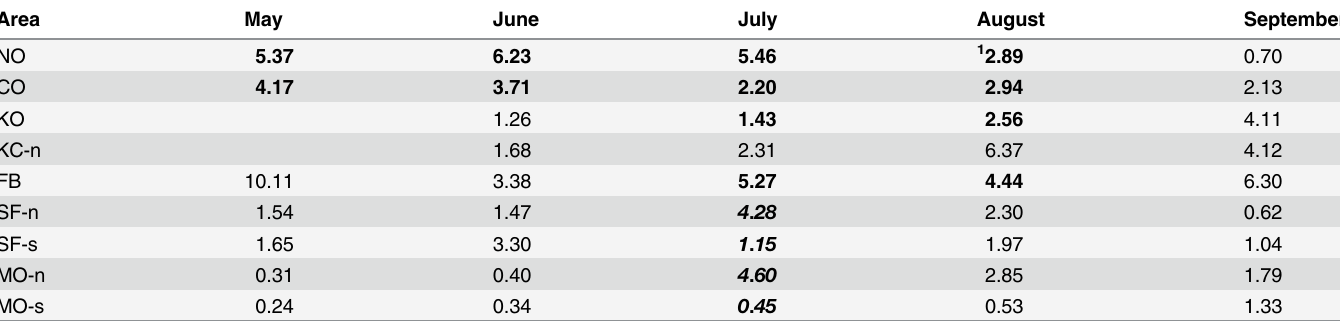
Table 3. Observed mean catch per unit effort (CPUE, vessel-day fishing effort).